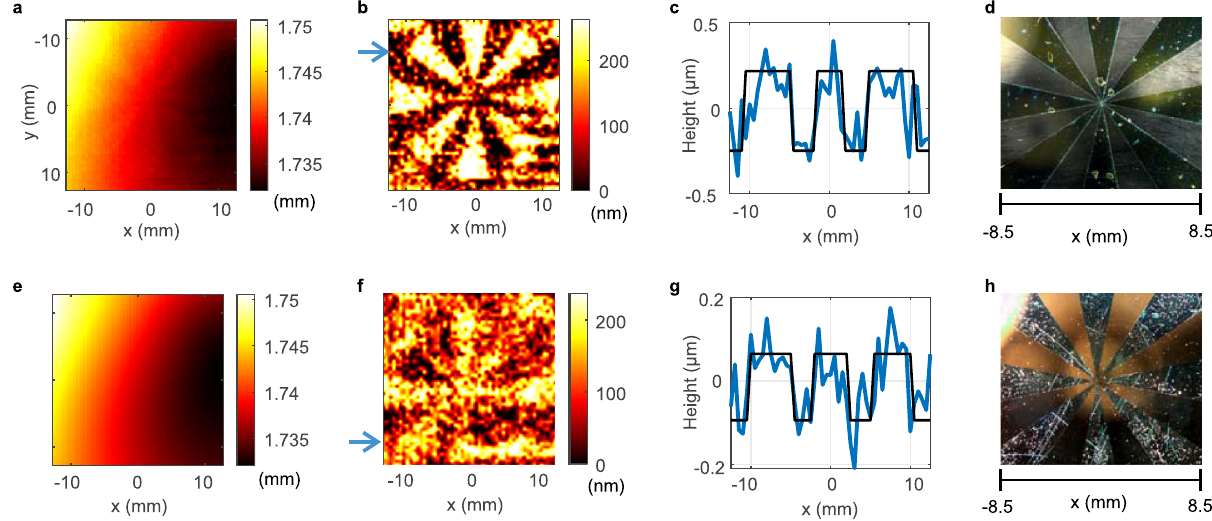
Fig. 3 Measurements of nanometric SiN and SiC Simens stars deposited on a silicon wafer. a Recorded Terahertz image. b Terahertz image of the 240 nm thick SiN Siemens star after subtracting the warping of the silicon wafer (shown in e ) and image enhancement. c Actual optical height pro fi le of the line indicated by the blue arrow in ( b ). d Optical micrograph of the center of the 240 nm thick SiN Siemens star on the silicon wafer. e Warping of the silicon wafer. f Terahertz image of the 49 nm thick SiC Siemens star on a silicon wafer. g Actual optical height pro fi le of the line indicated by the blue arrow in ( f ), after subtraction of warped background. h Optical micrograph of the 49 nm thick SiC Siemens star. The color scales of the terahertz images represent the optical